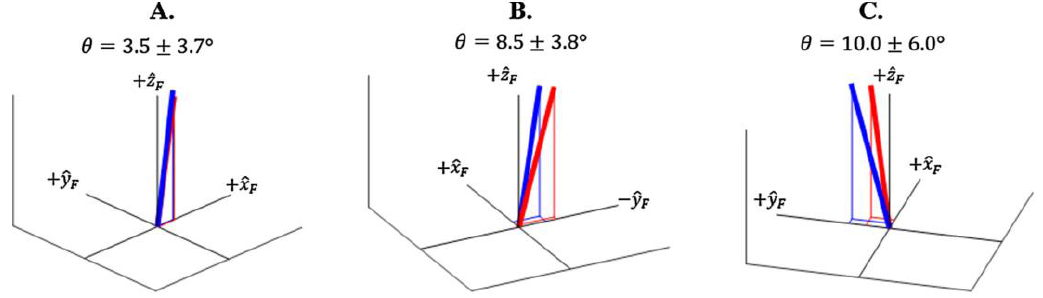
Figure 9. Graphical representation of the GRF vector estimated by the IMU (red) and by the force platform (blue) as found by [56]. ( A ) sprint start task, ( B , C ) change of direction tasks. Angular error between the vectors is represented.